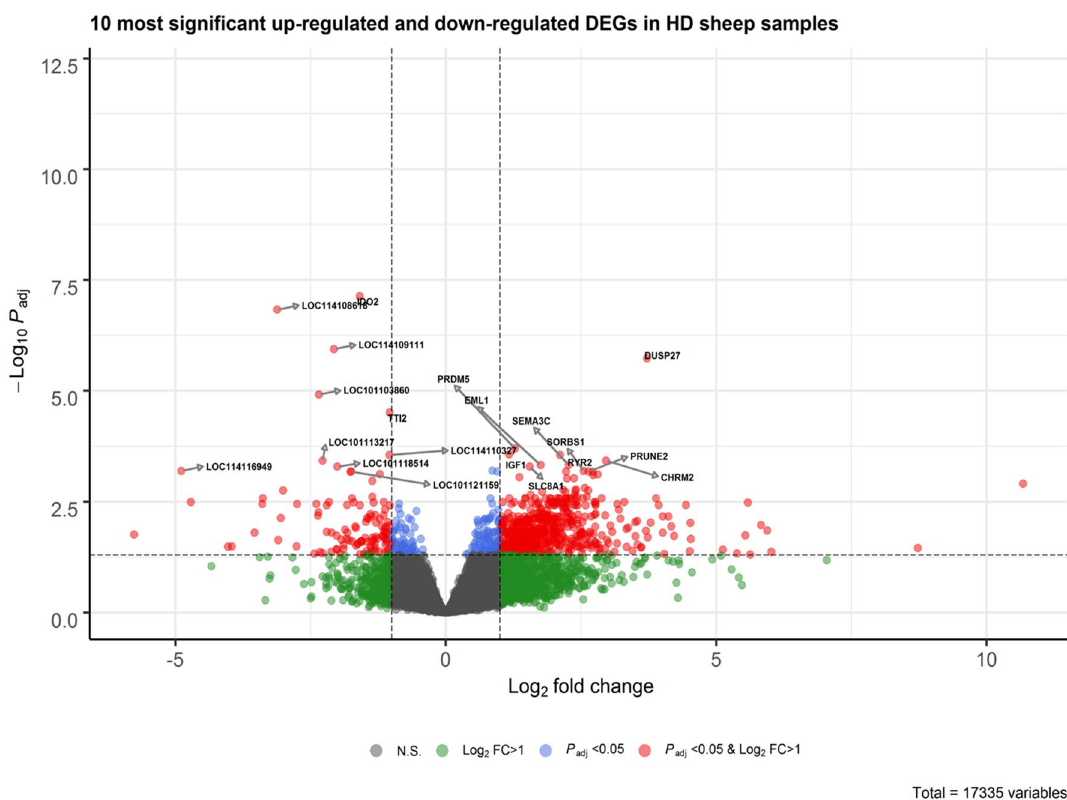
Figure 4. Volcano plot showing the 10 most significant up-regulated and down-regulated DEGs in HD sheep duodenal